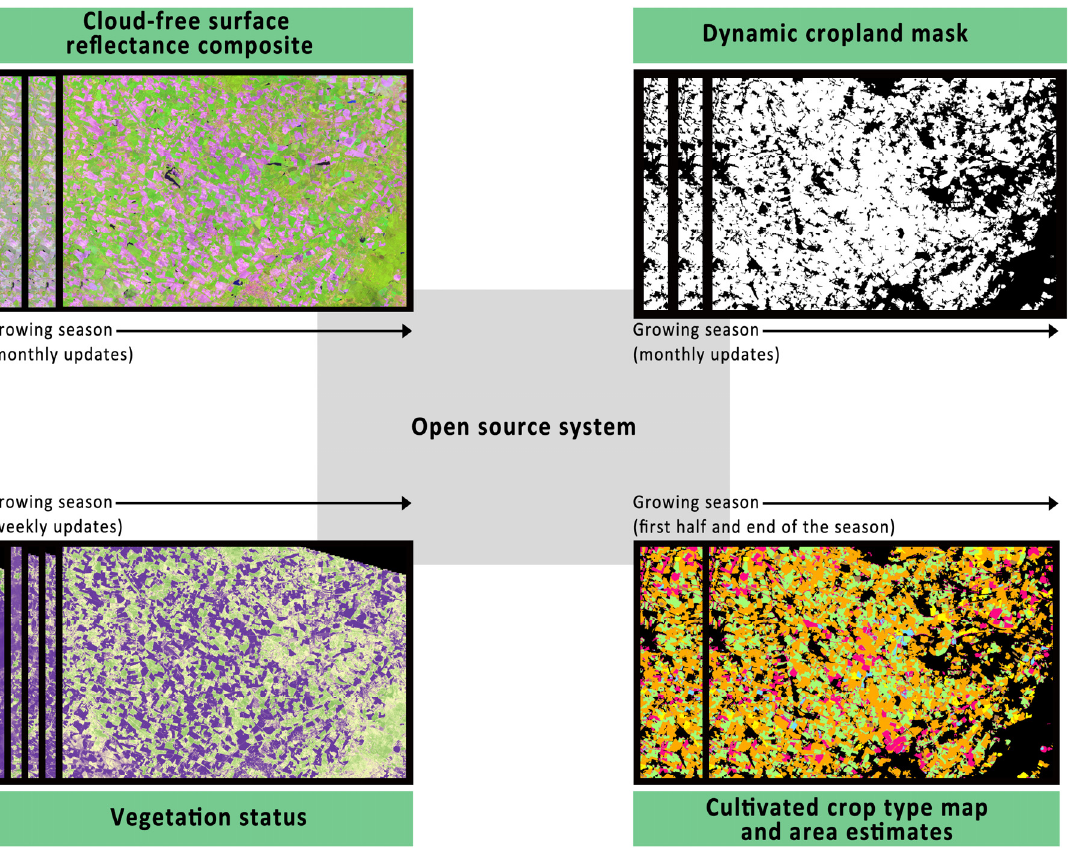
Figure 1. Suite of the four validated Sentinel-2 derived agricultural products.